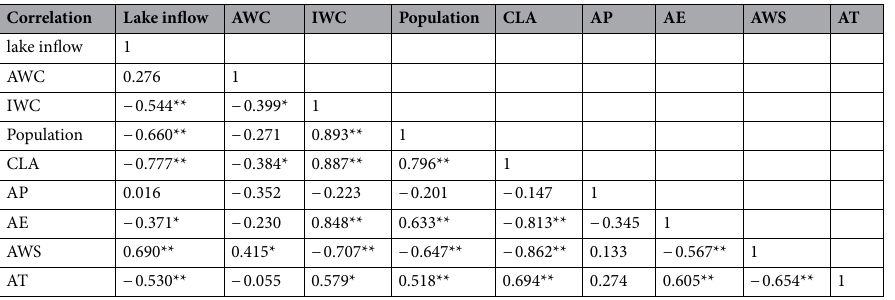
Factor PC1 PC2 PC3 AWC − 0.397